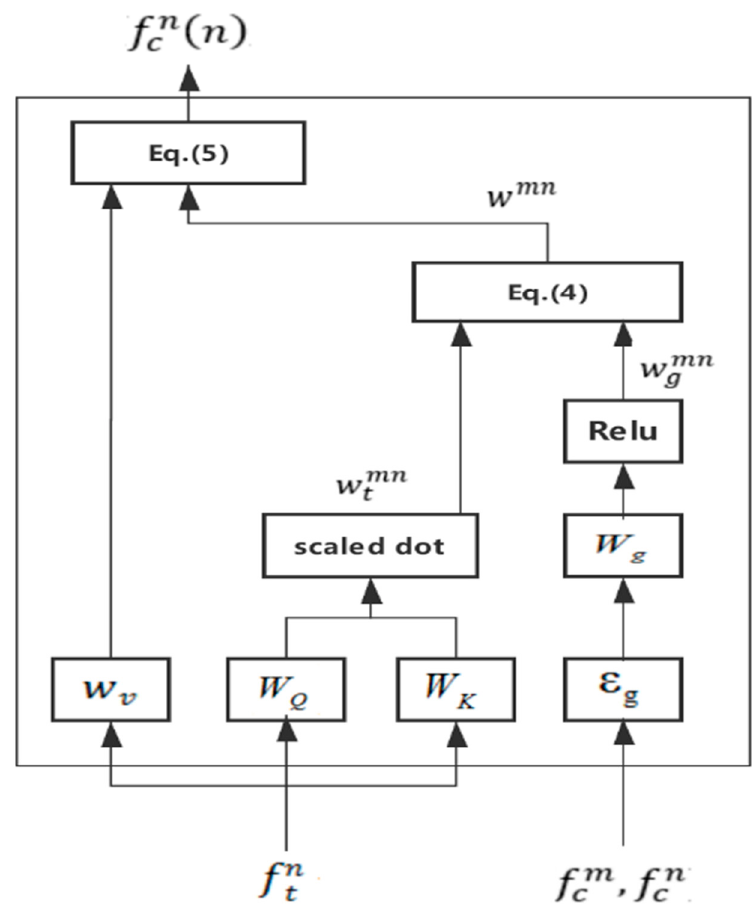
Figure 3. Relation channel module.